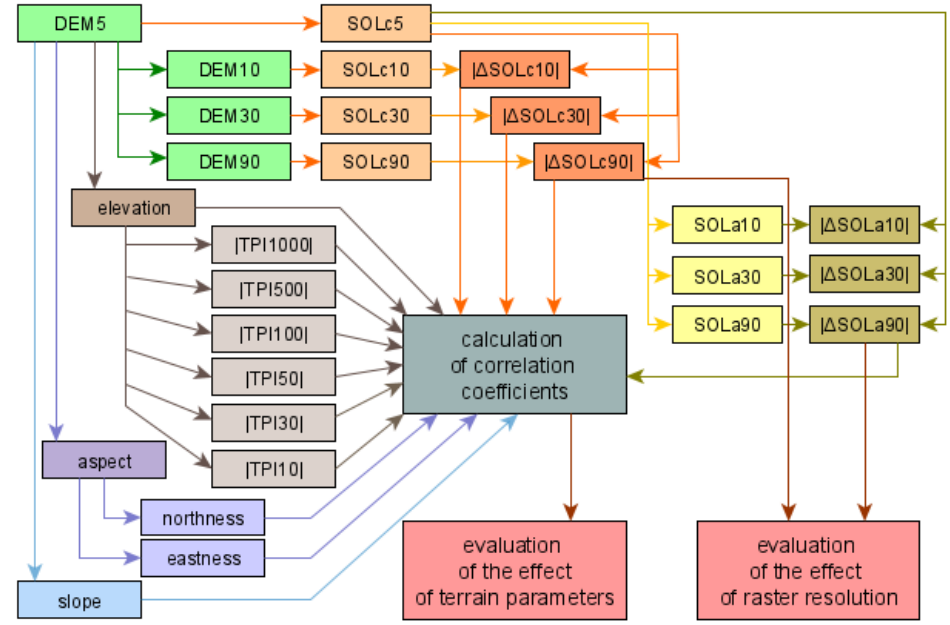
Figure 3. The design of an experiment to assess the effects of terrain parameters and spatial resolution of DEM on the calculation of potential solar radiation: DEM x —DEM with a spatial resolution of x m; SOLc x —potential solar radiation calculated from DEM at a resolution of x m; SOLa x —potential solar radiation aggregated at a resolution of x m; | ∆ SOLc x |/| ∆ SOLa x |—the absolute value of the difference between the values of SOLc5 and the values of potential solar radiation calculated / aggregated at a resolution of x m; |TPI y |—topographic position index calculated with a neighbourhood of y m.